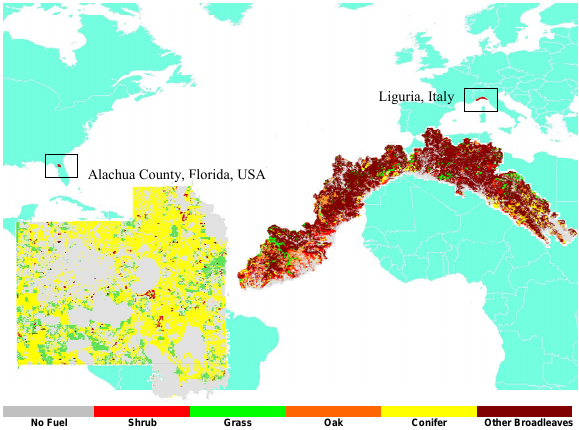
Fig. 1. Location map of the study areas. The land cover of Alachua County and Liguria (in red within the box) are reported on the left and on the right, respectively.